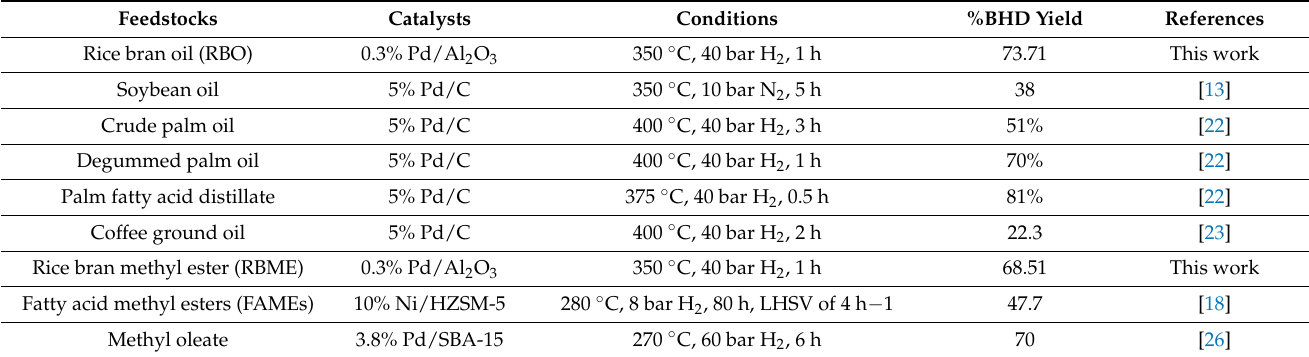
Table 4. Comparative green diesel production from different